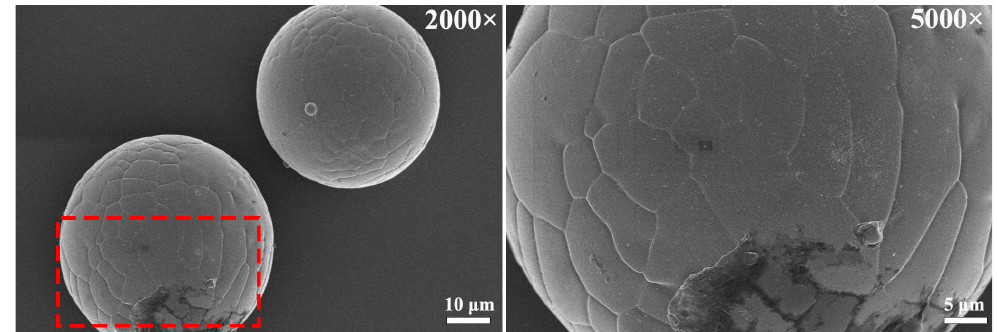
Figure 1. SEM morphology of Al-Li alloy microparticles.